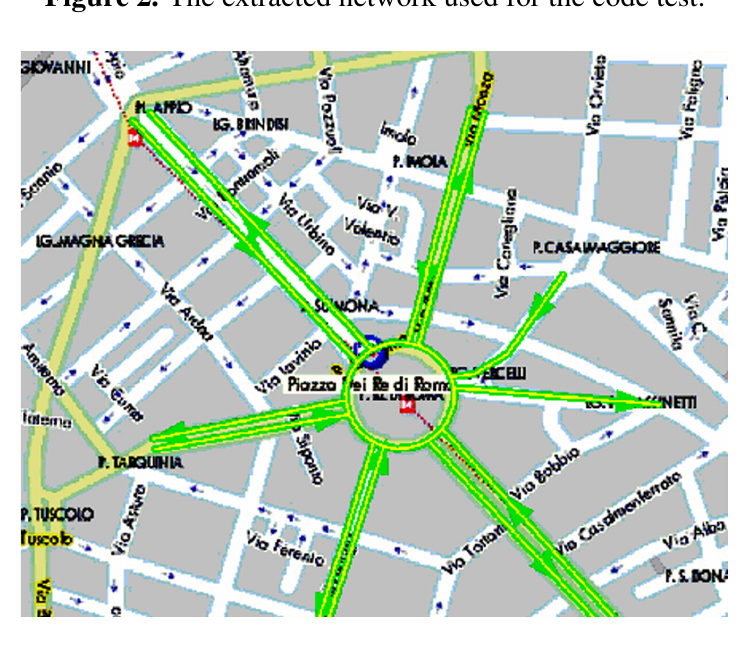
Figure 2. The extracted network used for the code